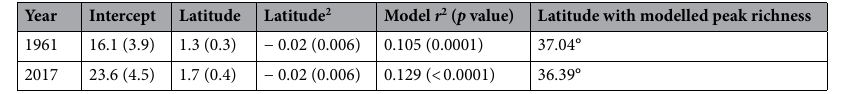
Table 1. Parameters and diagnostics for linear regression models (including a 2nd-order polynomial term) predicting crop group richness as a function of latitude in 1961 and 2017. Only the 164 countries with data from both years were included in these analyses. Parameter estimate standard errors shown in parentheses. Also shown are the latitudes at which crop group richness peaked, according to these models, which are shown visually in Fig. 3.